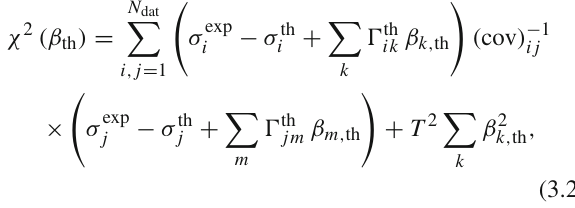
Fig. 3 Comparison between the baseline PDF4LHC15 set and the sets profiled with the LHC data, either with or without the correlations between the experimental systematic uncertainties accounted for. In the latter case, the f corr factor is chosen to reproduce the results of the profiling when the correlations are included, see text. We show here